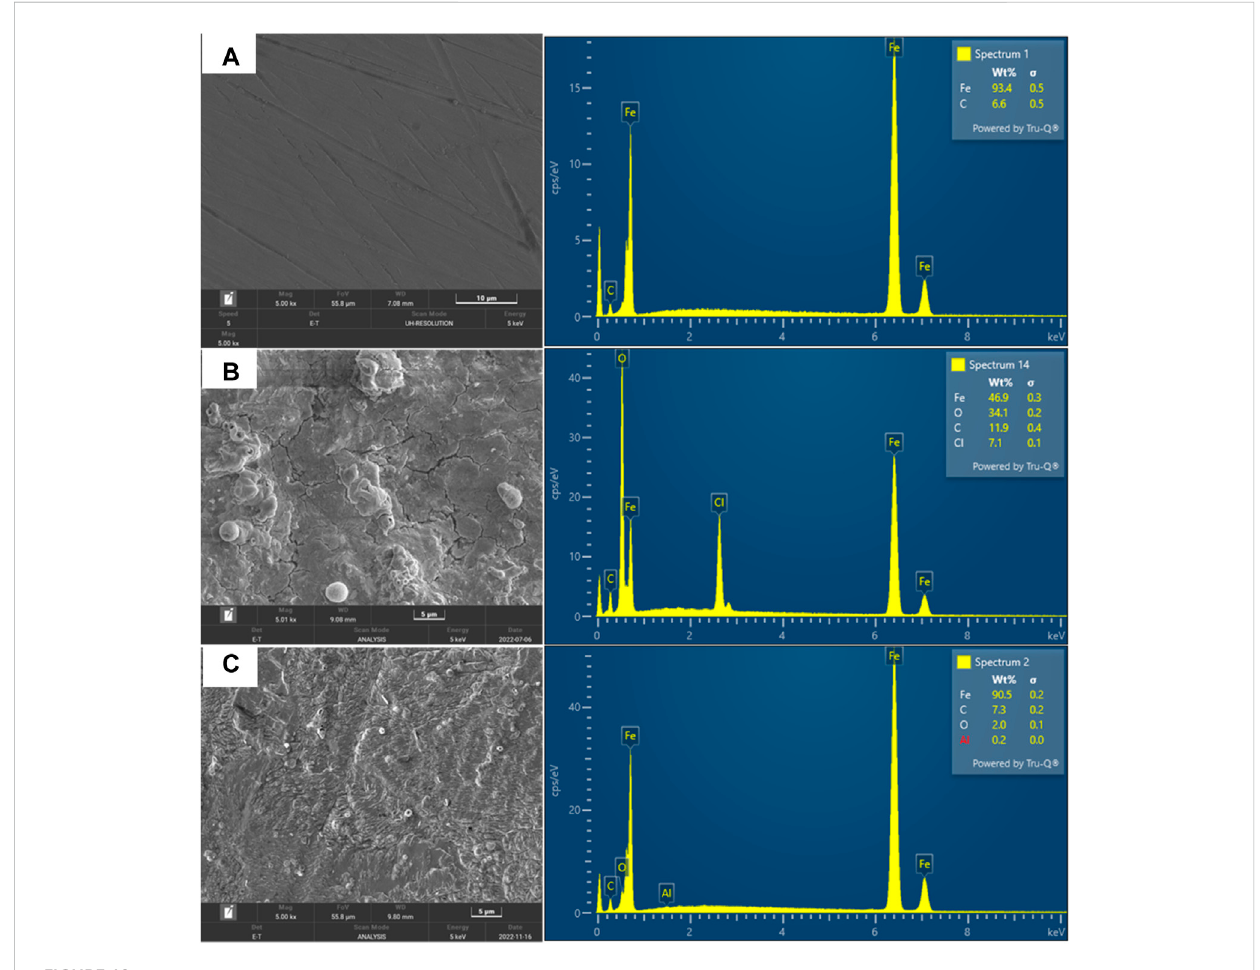
FIGURE 19 FESEM micrograph of mild steel metal: (A) before corrosion, (B) corrosion in the absence of inhibitor (C) corrosion in the presence of 800 ppm inhibitor.